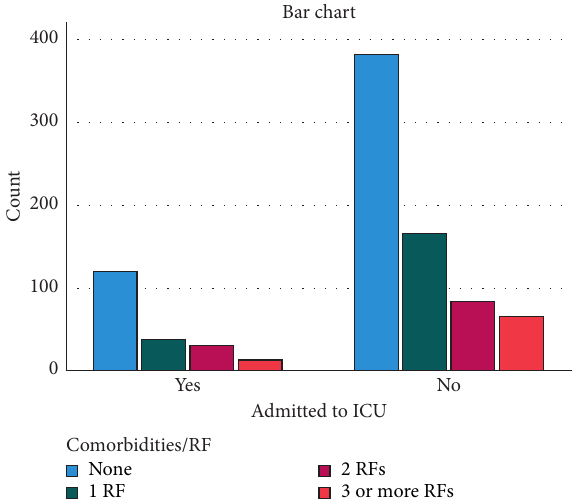
Figure 4: Number of patients admitted to ICU in relation to risk